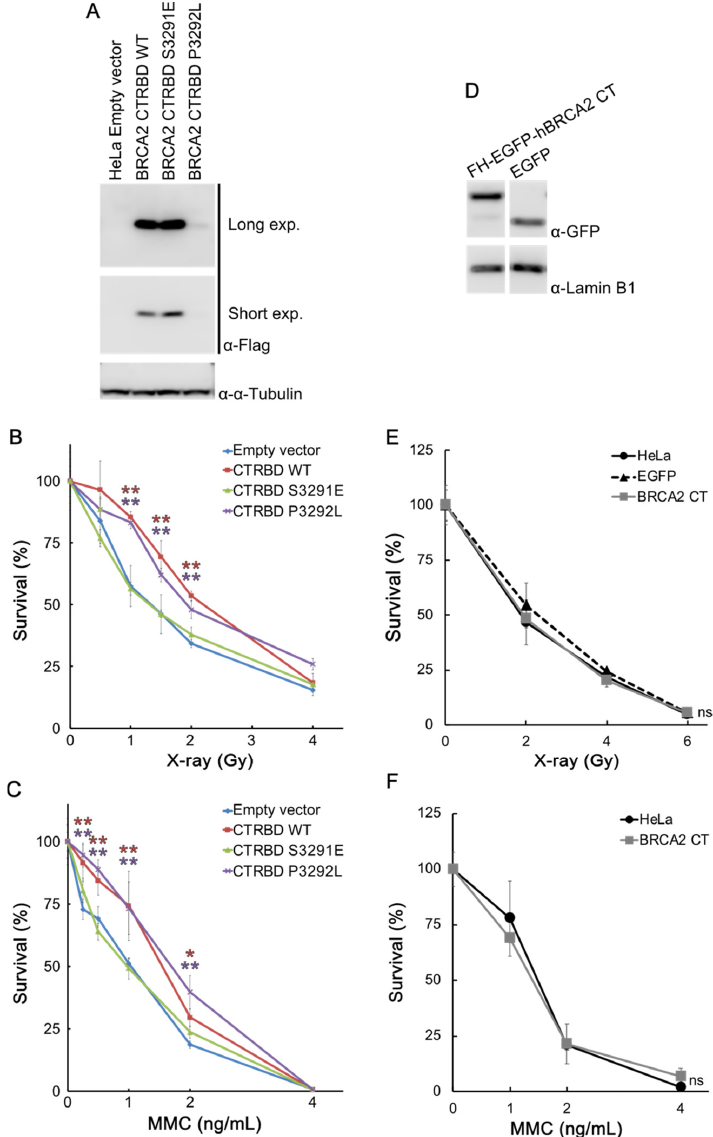
Figure 2. The BRCA2 CTRBD but not the BRCA2 C-terminus confers resistance to X-ray irradiation and mitomycin C (MMC) treatment. ( A ) The expression of the exogenous FLAG-HA-fused BRCA2 CTRBD (3260–3331 aa) and its mutants (S3291E and P3292L) was evaluated via Western blotting using anti-FLAG antibody. Long exp., long exposure; Short exp., short exposure. ( B , C ) A clonogenic survival assay of FLAG-HA-fused BRCA2 CTRBD (3260–3331 aa)-expressing cells treated with X-ray irradiation or MMC is shown. Results are presented as the mean at each X-ray or MMC dose, and error bars indicate the standard deviation ( n = 3). Significance was examined by an F-test, followed by Student’s t -test with Holm’s correction. Asterisks indicate significant differences between empty vector-transduced HeLa cells and FLAG-HA-fused wild-type or P3292L-mutated BRCA2 CTRBD-expressing cells (* p < 0.05, ** p < 0.01). ( D ) Expression of the exogenous FLAG-HA-EGFP-fused BRCA2 C-terminus (3260–3418 aa) was determined by Western blotting using anti-GFP antibody. ( E , F ) A clonogenic survival assay of FLAG-HA-EGFP-fused BRCA2 C-terminus- and FLAG-HA-EGFP-expressing cells was performed after X-ray irradiation or MMC treatment. Results are presented as the mean at each X-ray or MMC dose, and error bars indicate the standard deviation ( n = 3). Significance was examined by an F-test, followed by Student’s t -test with Holm’s correction. ns, non-significant; CT,